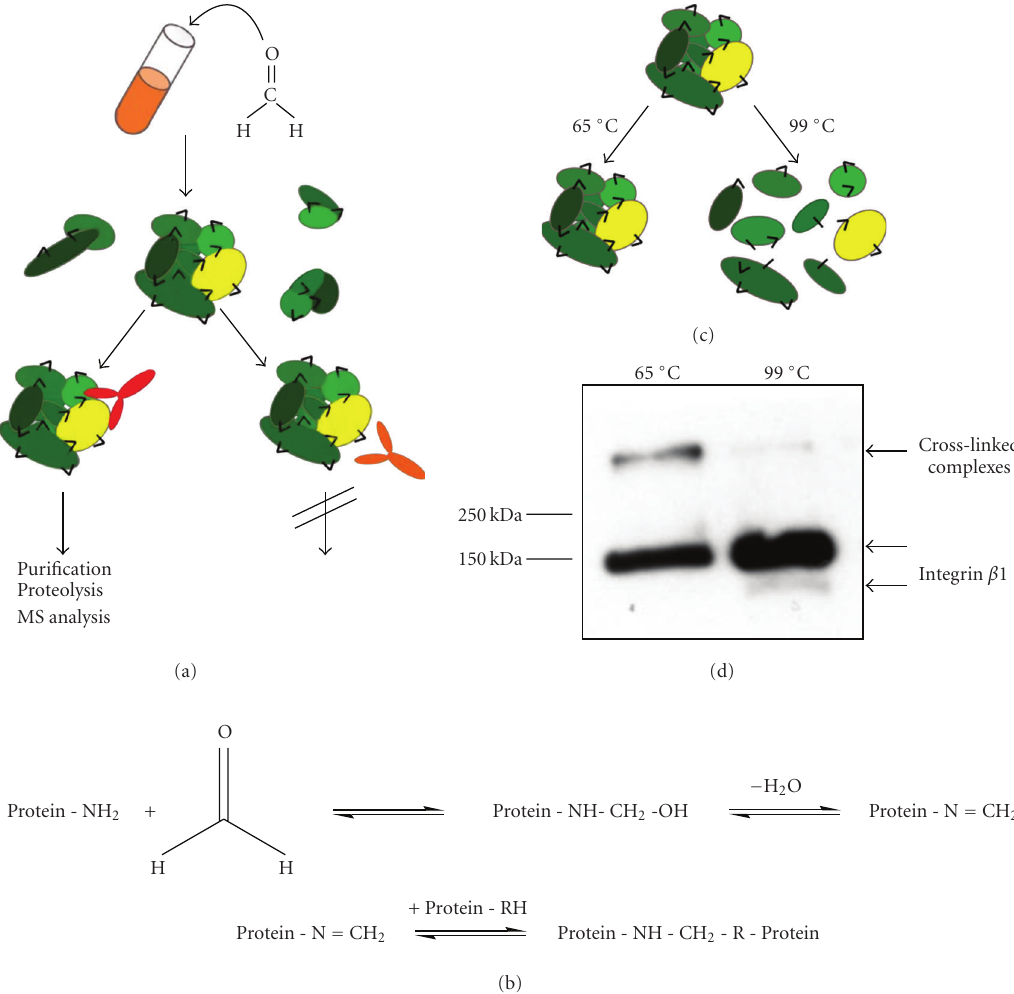
Figure 1: Formaldehyde cross-linking. (a) Workflow of formaldehyde cross-linking. Cells are treated with formaldehyde, lysed and protein complexes (oval shapes) are precipitated by antibodies ( y -shaped). Cross-links are indicated by black triangles. Only antibodies, whose epitopes are not destroyed during formaldehyde modification, can precipitate the complex. (b) Reaction scheme of formaldehyde modification, cross-linking and cross-linking reversal. (c) and (d) Formaldehyde derived cross-links are preserved, if samples are only incubated at 65 ◦ C, whereas most of the cross-links are reversed at 99 ◦ C. (c) Schematic model. Proteins are depicted as oval shapes, formaldehyde cross-links as black triangles. (d) Anti-integrin β 1 immunoblot analysis of cross-linked Jurkat cells (JB1A, anti-mouse